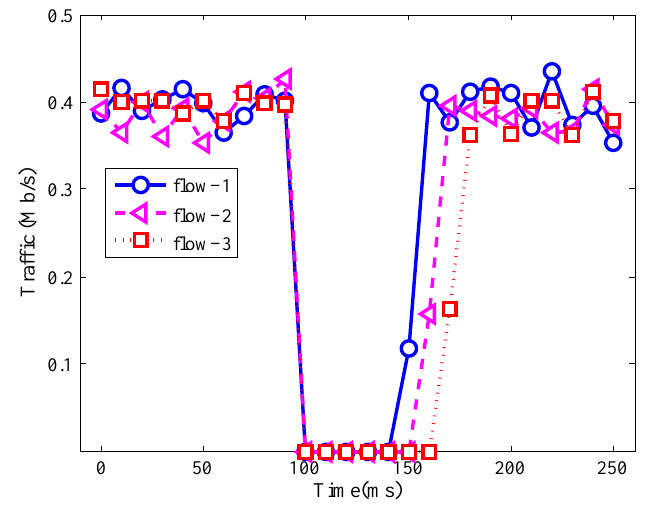
Figure 4. Traffic during s2e link